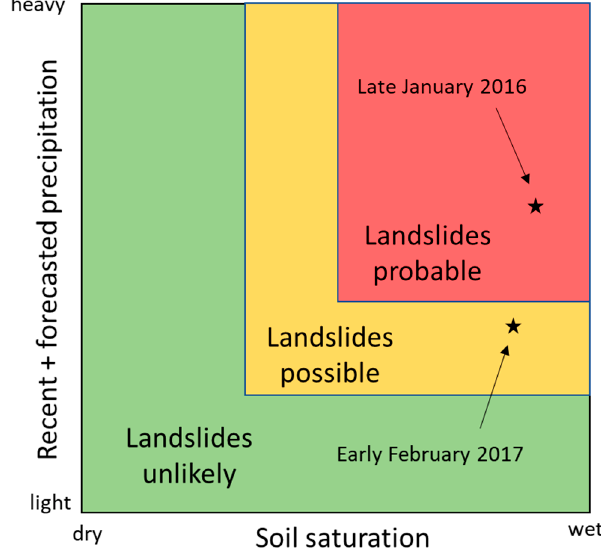
Figure 12. Qualitative example of an operational implementation of the dual hydro-meteorological threshold plots, showing a general audience when landslides are unlikely, possible and probable. Whereas the late January 2016 events in Seattle would have plotted in the highest hazard zone, the early February 2017 events would likely have plotted in the moderate hazard zone (see Figure 10).